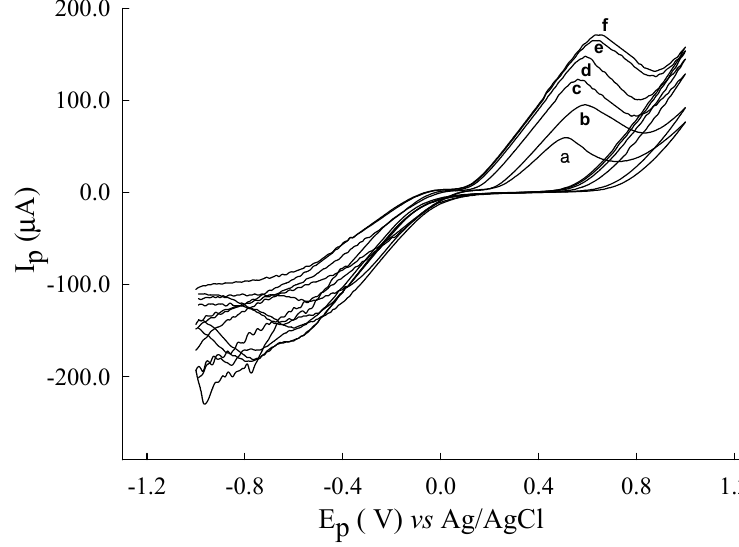
Figure 1. The growth patterns for a Au -coated carbon fibre (CFE), deposited from 4 mM (Hydrogen tetrachloroaurate ( Ⅲ ) trihydrate) in 0.1 M acetate buffer (pH 4.97) HAuCl 4 ( c ) third scan ( d ) fourth scan ( e ) fifth scan ( f ) sixth scan, from − 1.0 V to 1.0 V on a carbon fiber microelectrode (44.34 μ m 2 surface area), scan rate, 100